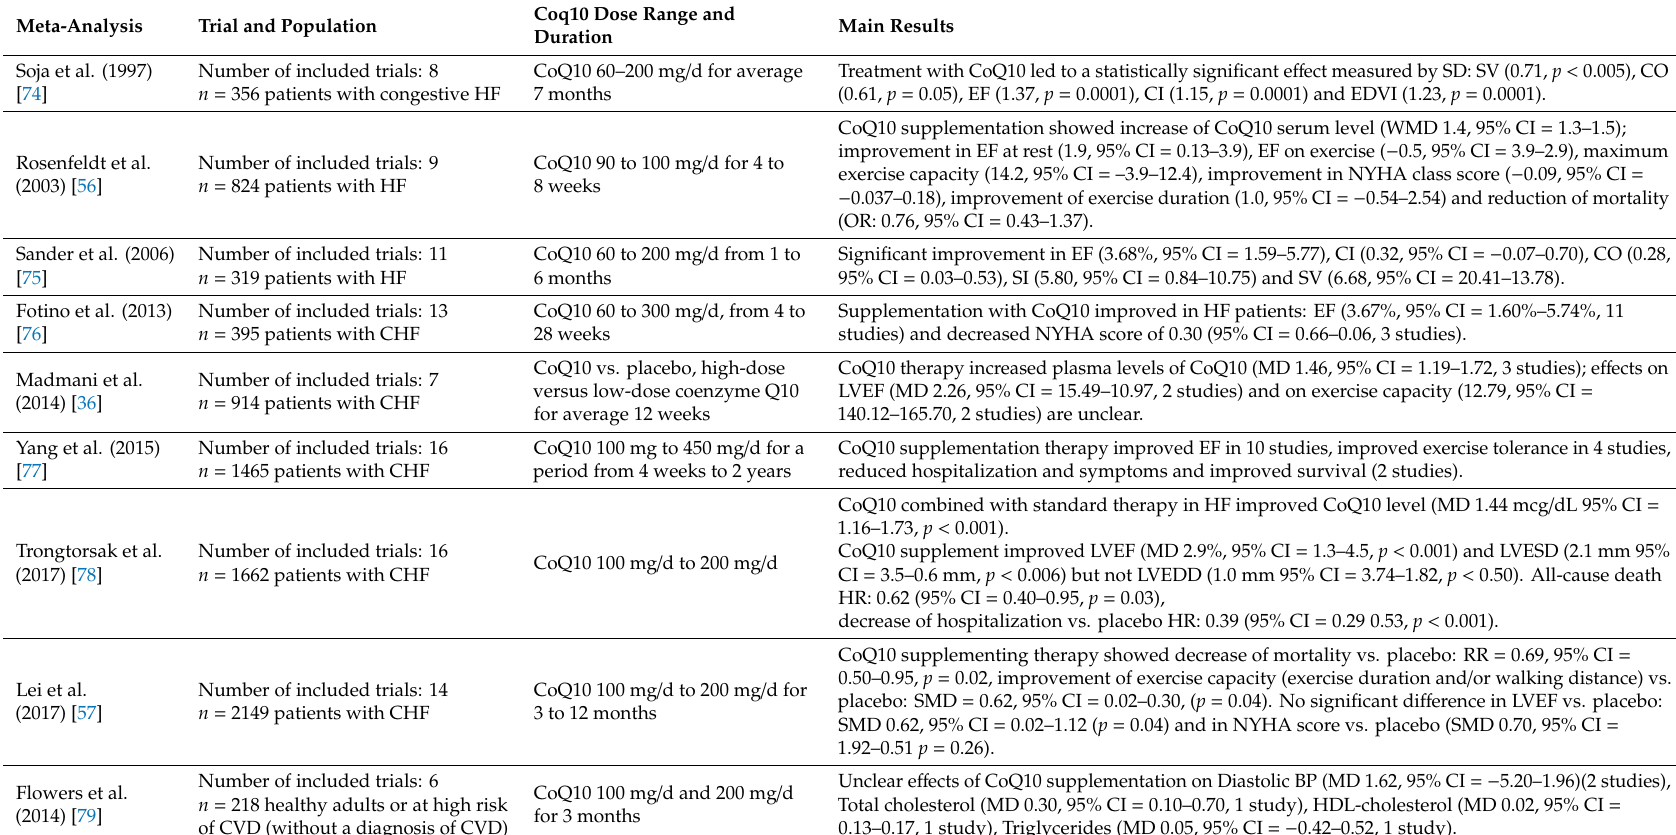
Table 2. Principal data from